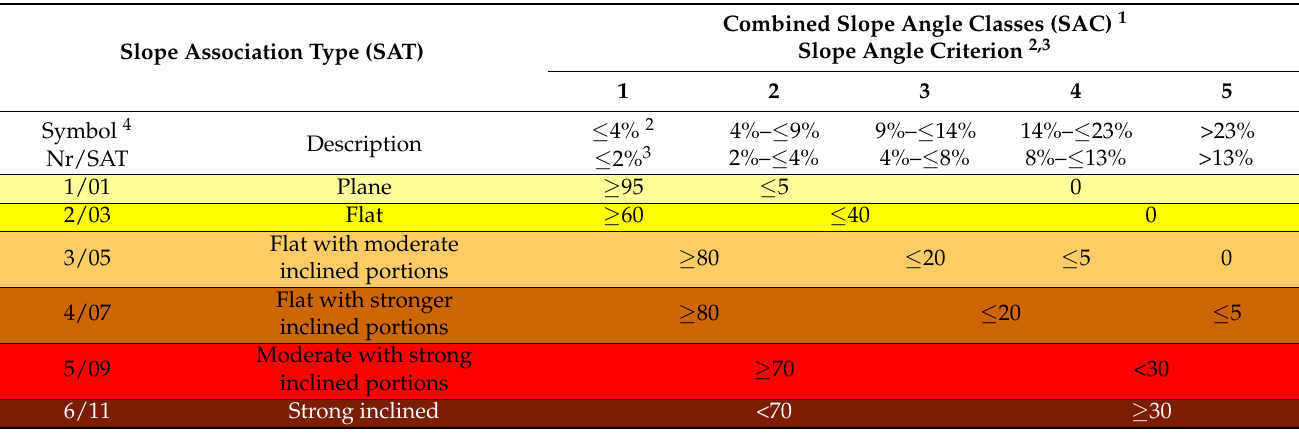
Combined Slope Angle Classes (SAC)